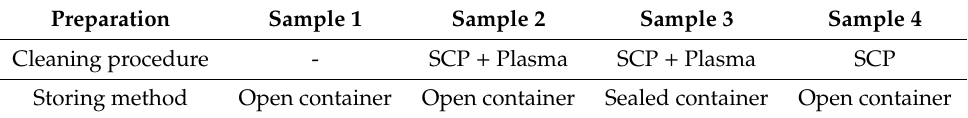
Table 1. Details of the cleaning procedure and storing method of the samples.